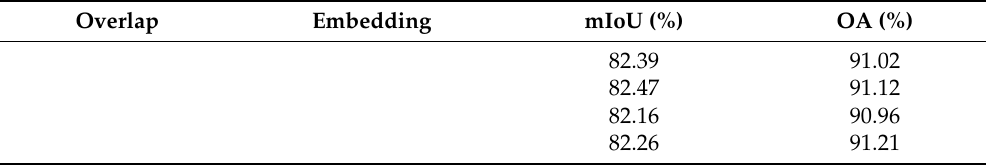
Table 4. Different downsample scheme on Vaihingen test set. Model size is B4. Convolution on the non-overlapped patch has an even kernel size the same as strides, while overlapped patch merging uses odd kernel size convolution with stride half of kernel size. Patch embedding changes the dimension of convolution output from 1 to C (a user parameter, influence of C, is studied in [32]). Here, the method using no embedding just copies output and expands it to the C dimension.